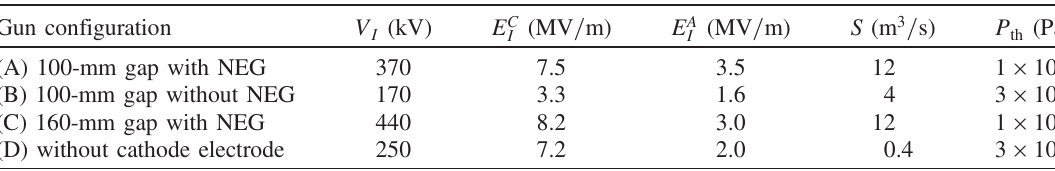
TABLE III. Experimental results for prebreakdown initiation voltage V I and absolute values of maximum surface electric field on cathode E C I and anode E A I at which prebreakdown activity in the gun chamber began for various gun configurations. Effective pumping speed S and threshold vacuum pressure P th above which Eq. (4) is integrated to obtain total gas desorption during HV conditionings are also listed. The gun chamber was cleaned with the same procedure described in Sec. IVA for all the configurations except for (D). The gun system was baked at 170 °C for roughly 50 h for every gun configuration to prepare similar initial condition of the gun chamber and the ceramic insulator prior to each HV conditioning.